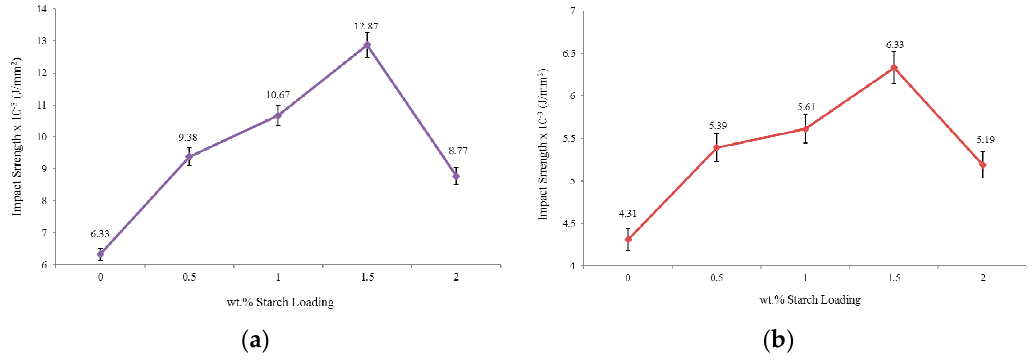
Figure 6. Impact strength ( a ) un-notched specimens and ( b ) single-notched specimens.